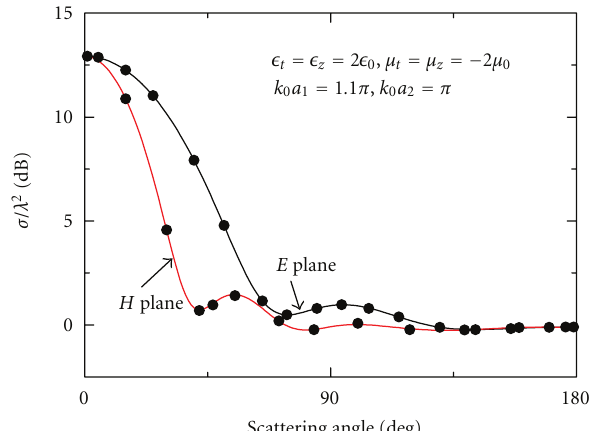
Figure 2: Radar cross sections (RCSs) versus scattering angle θ (in degrees): results of this paper (solid curve) and of Mie theory (black round).